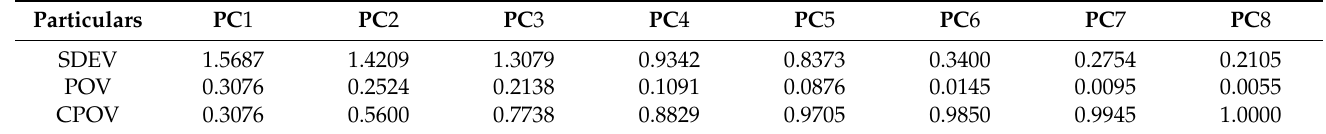
Table 2. Realizations of PCA.